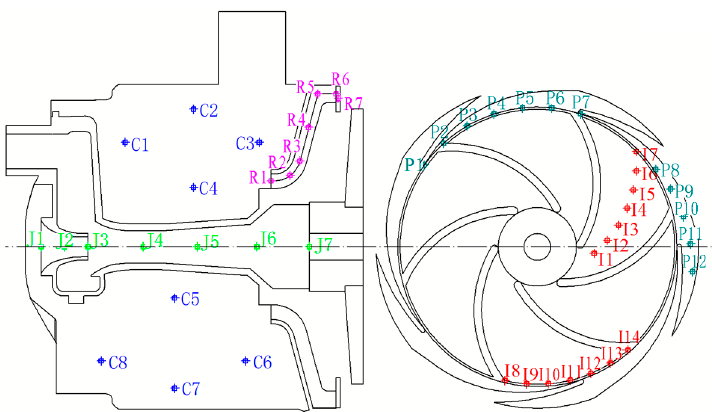
Figure 15. A schematic diagram of the positions of the monitoring points in each component.